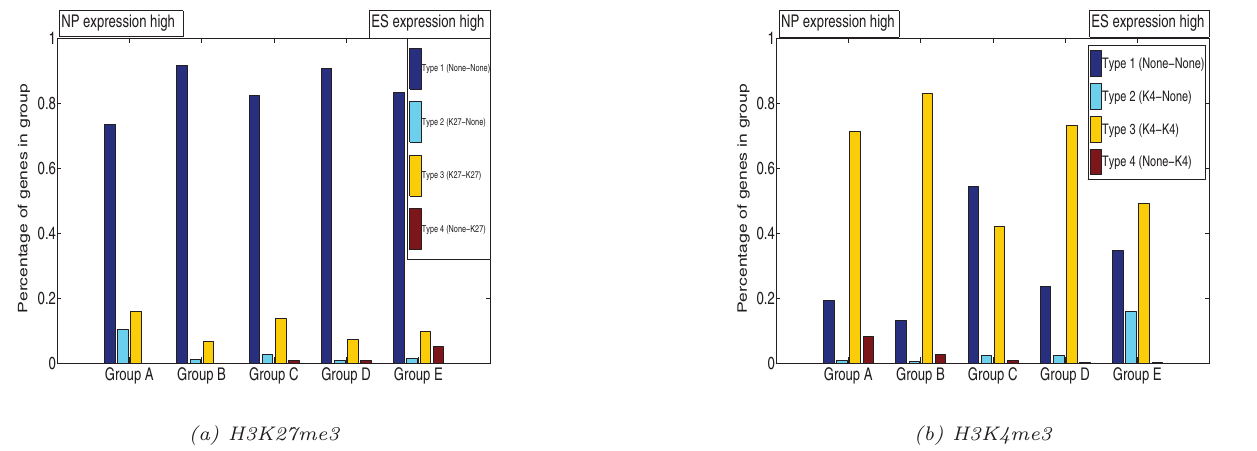
Figure 10. Gene profile according to expression and histone modifications. Genes are grouped in (A–E) according to increasing ratio of expression level in ES cells and NP cells. Within each groups, genes are classified into 4 types. Type 2 genes have differential histone enrichment in ES cells in their promoter regions and type 4 genes have differential enrichment in NP cells. (a) Percentage of type 2 genes is decreasing, while percentage of type 4 genes is increasing along the group (A–E). (b) Percentage of type 2 genes is increasing, while percentage of type 4 genes is decreasing along the group (A–E).